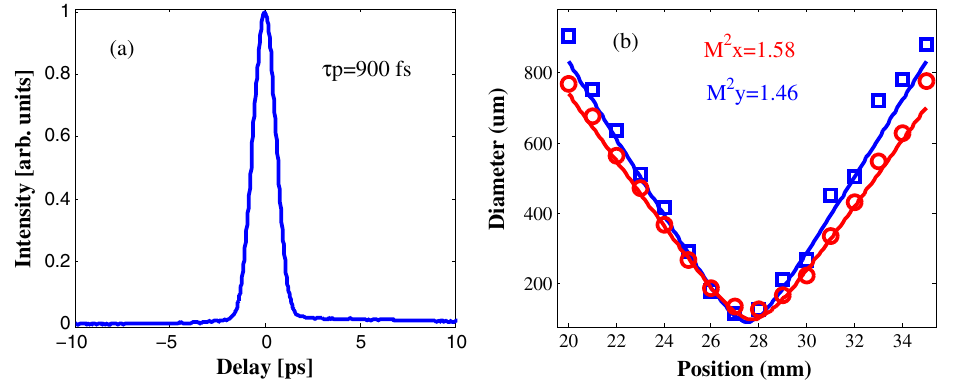
FIG. 10. (a) AC signal; and (b) M 2 measurement results of green light at 50